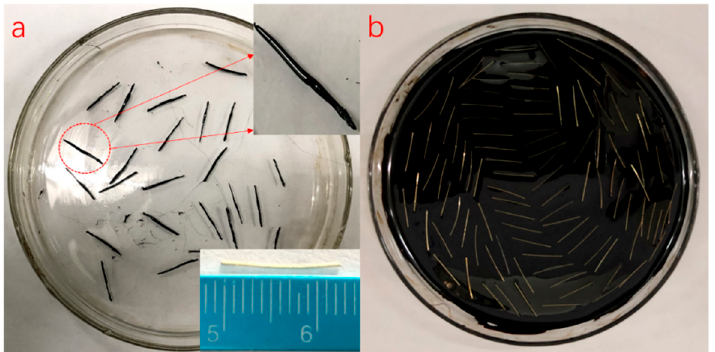
Figure 2. Dramix steel fibers coated with asphalt binder (DA) for ( a ) Fourier Transform Infrared (FTIR) and Four-Components Analysis (FCA) tests and ( b ) Dynamic Shear Rheometer (DSR) test.